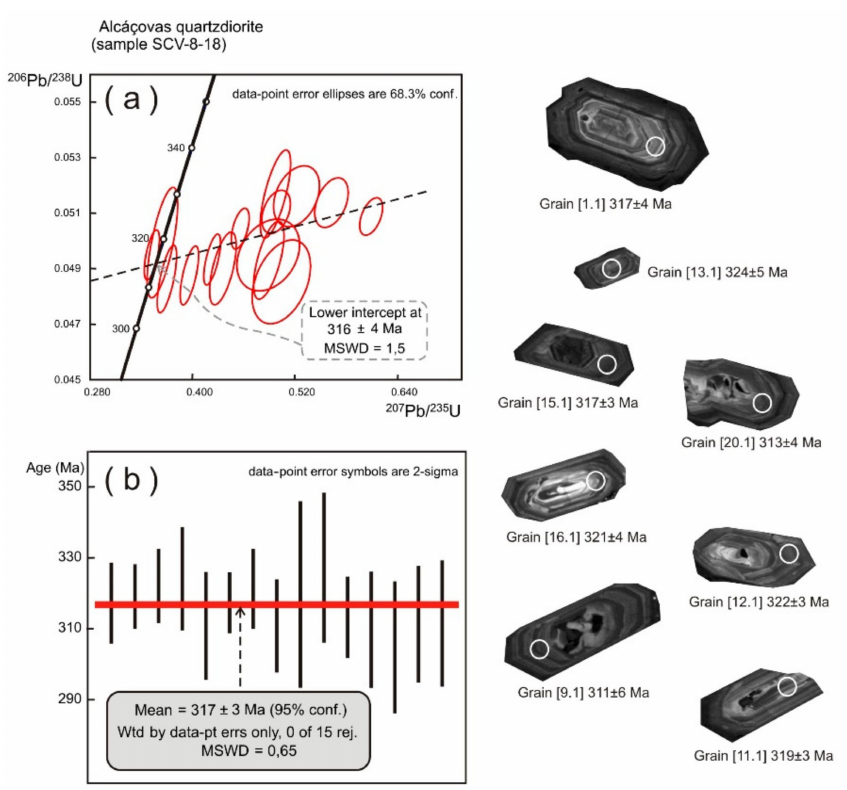
Figure 7. Concordia diagram and weighted mean of 206 Pb/ 238 U ages of analyzed zircon grains of the Alc á çovas quartz diorite. Cathodoluminescence images of representative zircon grains. Circle-analytical spot of approximately 25 micra. ( a ) Concordia plot; ( b ) weighted mean of 15 206 Pb/ 238 U